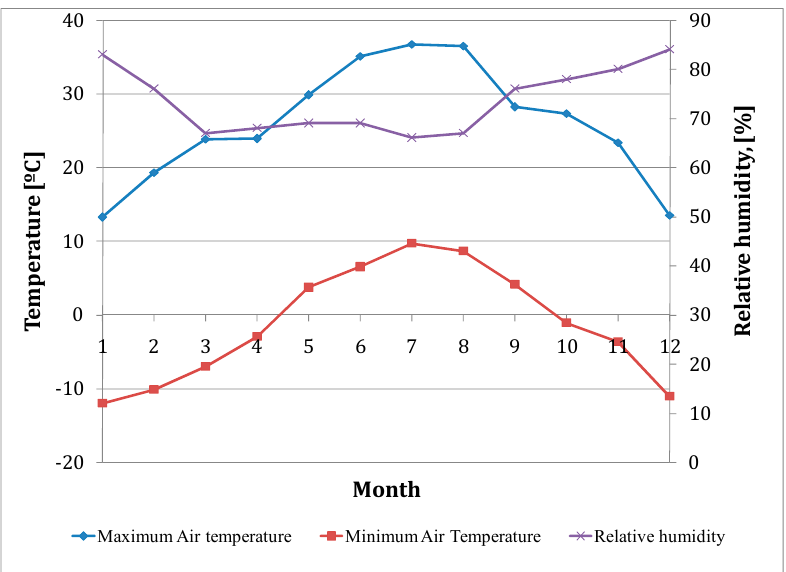
Figure 4. Monthly weather data for Belgrade, from EnergyPlus weather file.